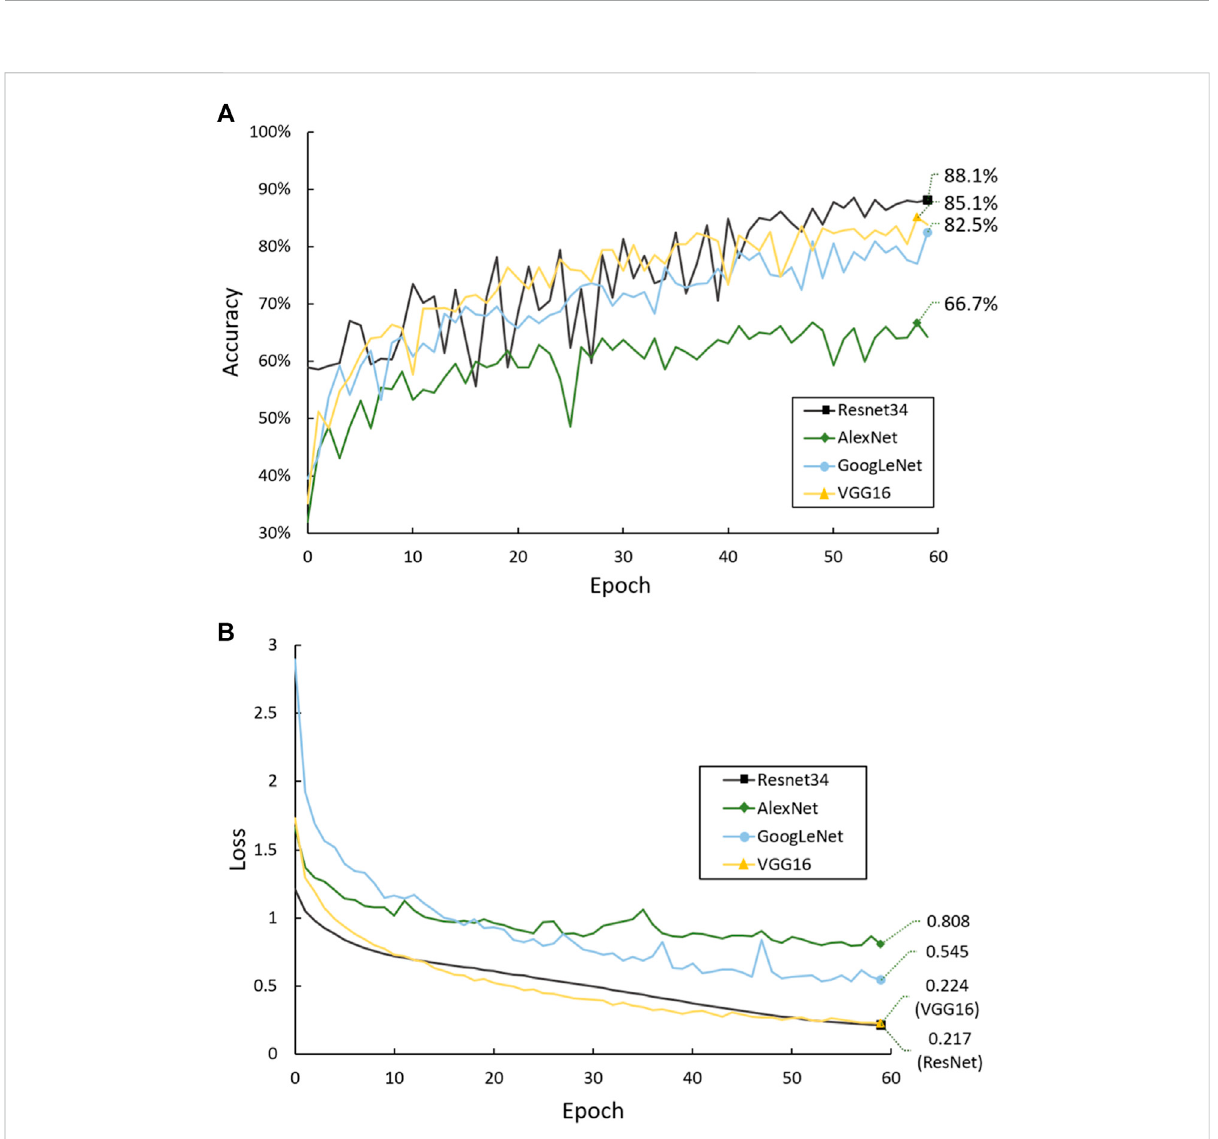
FIGURE 9 The accuracy (A) and the loss (B) values of four different models over different